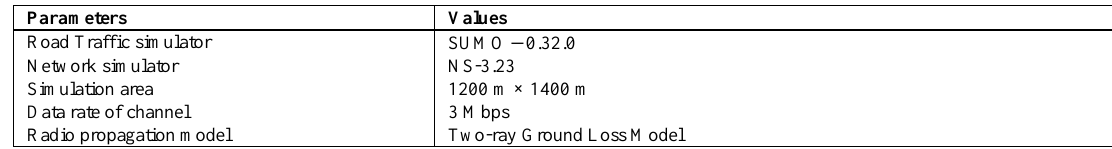
Table 2. Simulation